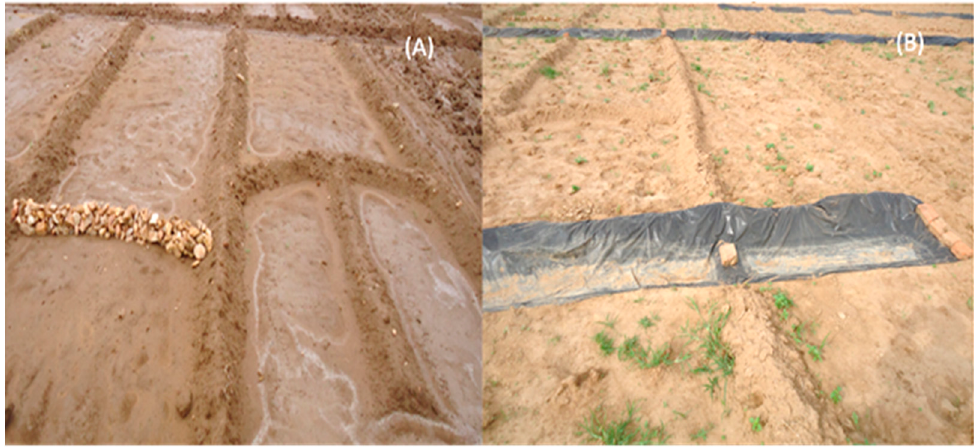
Figure 3. View of the prepared land of the experiment: ( A ) conservation tillage techniques; ( B ) collectors of soil particle deposits.